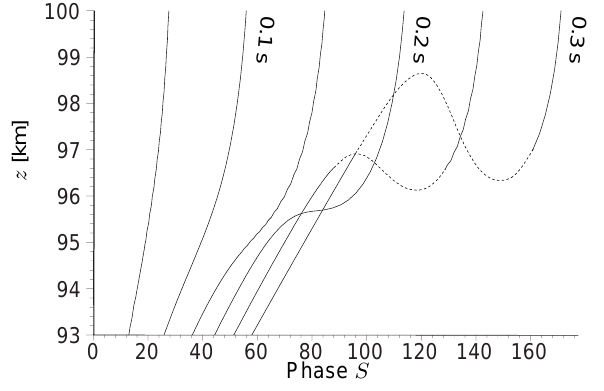
Fig. B1. Evolution of the phase S . Same as Fig. 4 but for a structure with a uniform initial aspect angle of + 0 . 5 degrees. The wave tears apart, as opposed to crashing into itself. The dotted parts of the lines correspond to the multi-valued part of the solution and have to be removed according to the algorithm described in Appendix